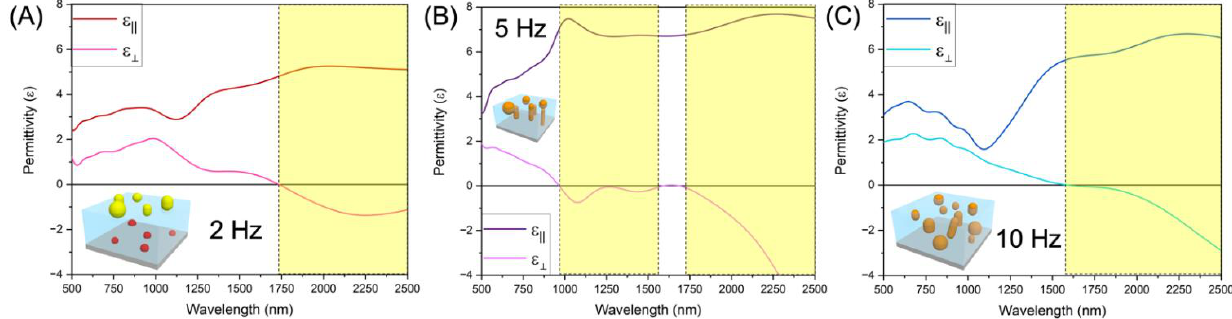
Figure 6. Optical permittivity of the Au-Fe-BTO sample grown at ( A ) 2 Hz, ( B ) 5 Hz, ( C ) and 10 Hz.